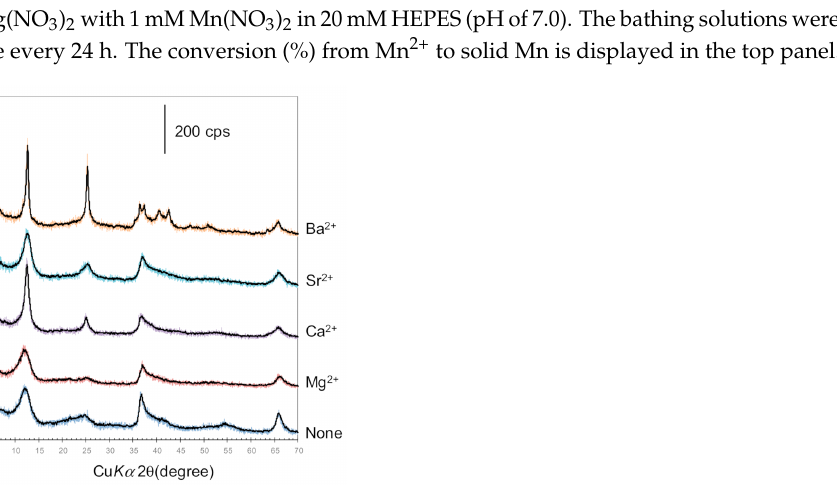
Figure 7. X-ray diffraction analysis of newly formed biogenic manganese oxides (1 mM as Mn) with mixed solutions of 10 mM Ba(NO 3 ) 2 , Sr(NO 3 ) 2 , C(NO 3 ) 2 , or Mg(NO 3 ) 2 with 1 mM Mn(NO 3 ) 2 in 20 mM HEPES (pH 7.0). Bathing solutions were renewed thrice every 24